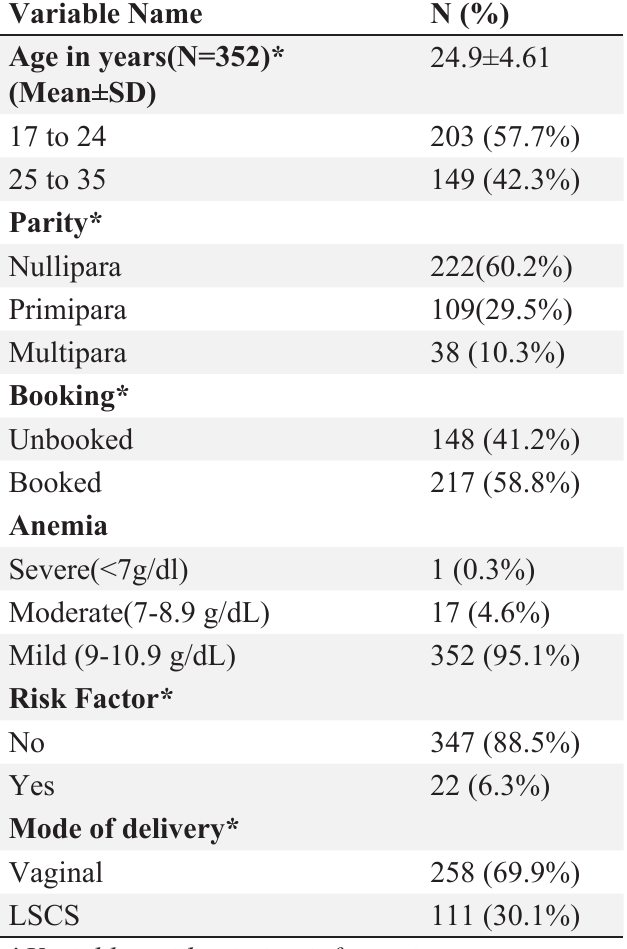
Table 1 Socio-Clinical characteristics of study par- ticipants